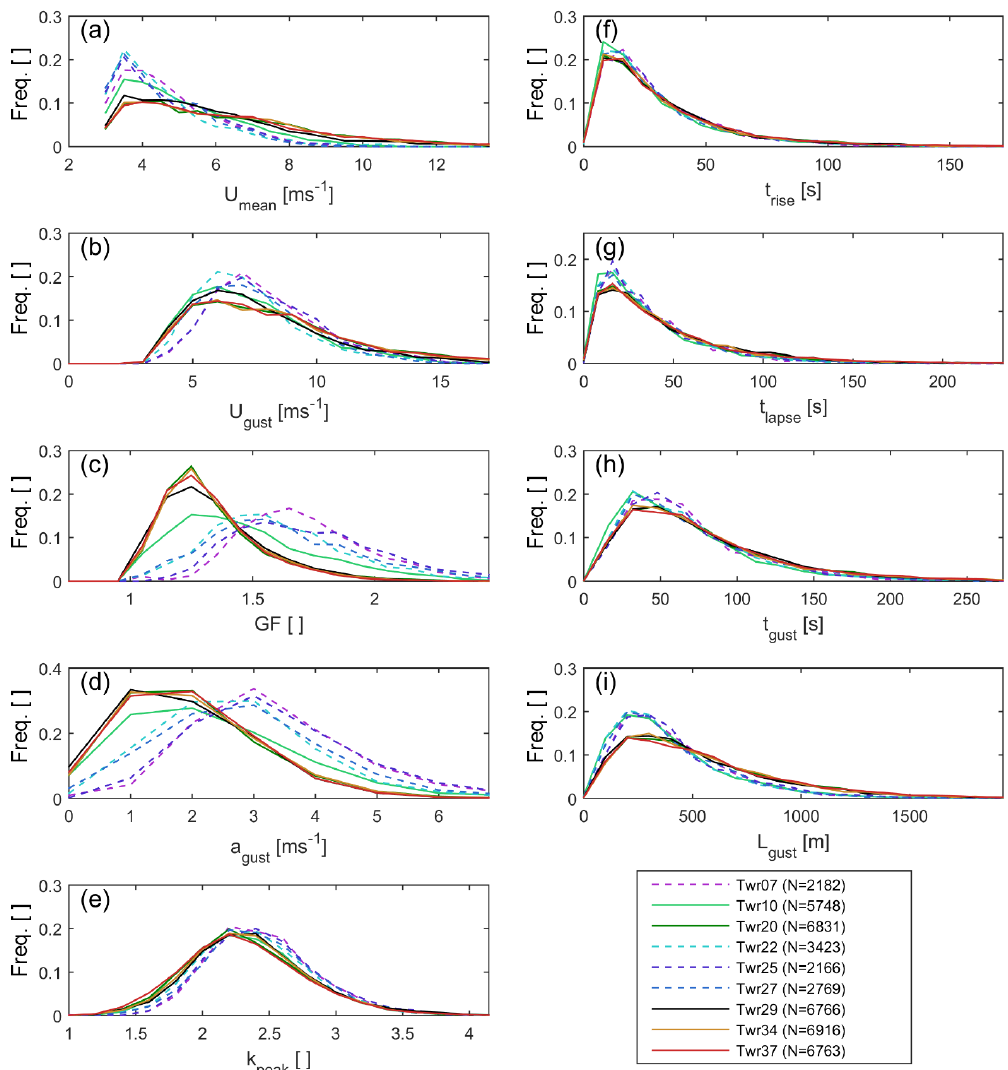
Figure 3. Distributions of gust parameters at each of the nine towers (using data collected at 60ma.g.l.) for 10min periods with U mean > 3ms − 1 . Valley towers are shown with dashed lines and ridge towers with solid lines. The frames show the (a) 10min mean wind speed ( U mean ), (b) gust magnitude ( U gust ), (c) gust factor (GF), (d) gust amplitude ( a gust ), (e) peak factor ( k peak ), (f) rise time ( t rise ), (g) lapse time ( t lapse ), (h) gust duration ( t gust ) , and (i) gust length scale ( L gust ). The legend reports the sample size ( N ) for 10min periods used to construct the empirical distributions for each tower. The towers are denoted by the color scheme introduced in Fig.